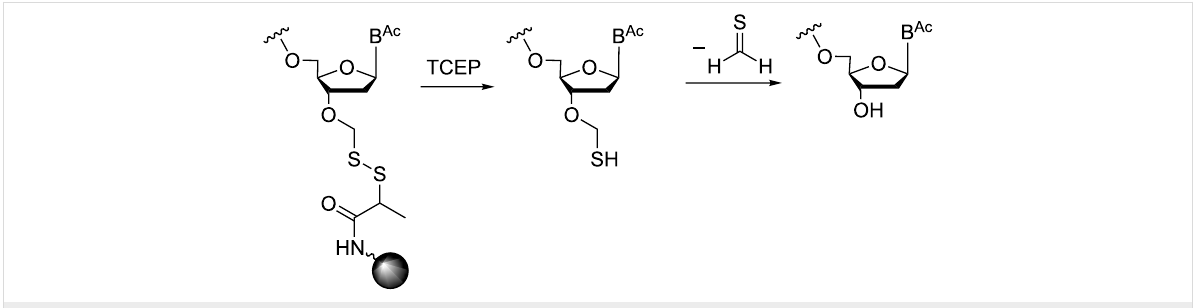
proceeded with a total 75–90% yield